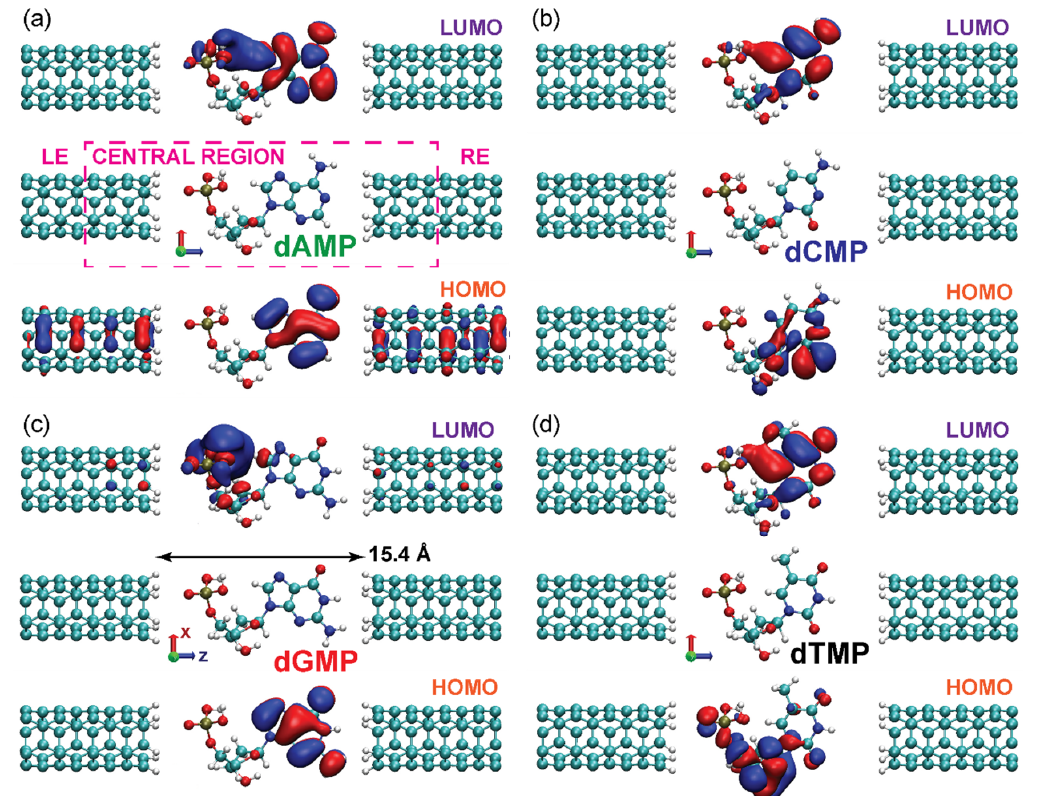
Figure 1. Deoxyribonucleotides ( a ) dAMP, ( b ) dCMP, ( c ) dGMP, and ( d ) dTMP between two H-terminated (3, 3) CNTs with 15.4 Å gap, i.e., the distance between H atoms of the left and the right tube, indicated by the black arrow in ( c ). The isosurfaces of the MPSH frontier orbital wave functions, HOMO and LUMO, calculated at zero bias, with the isovalues ψ HOMO/LUMO = –0.05 (blue) and ψ HOMO/LUMO = 0.05 (red). The central region, the left, and the right bulk electrode for the finite-bias calculations are marked with the dashed magenta rectangle, LE, and RE in ( a ). Red, green, and blue arrows indicate x , y , and z axes, respectively.